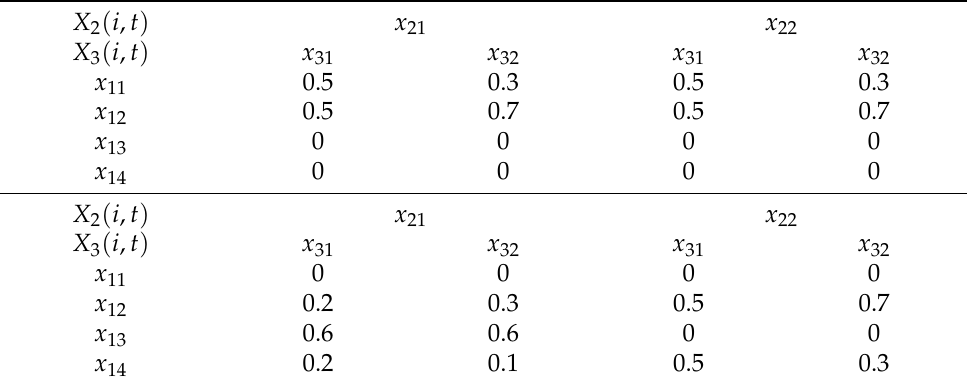
Table 10. CPDs of the future state with one to four infectious devices and with the initial states: susceptible (on the left) and infectious (on the